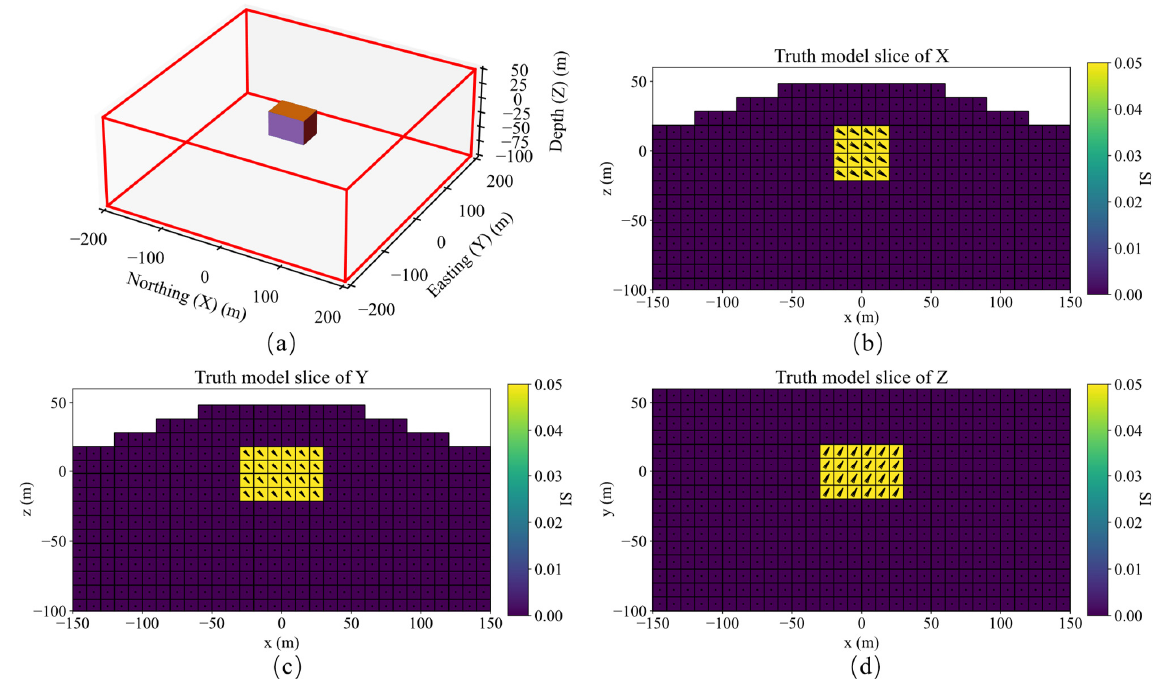
Figure 4. ( a ) Schematic diagram of a single model; Slices of magnetization vector model along the X ( b ), Y ( c ), and Z ( d ) directions.